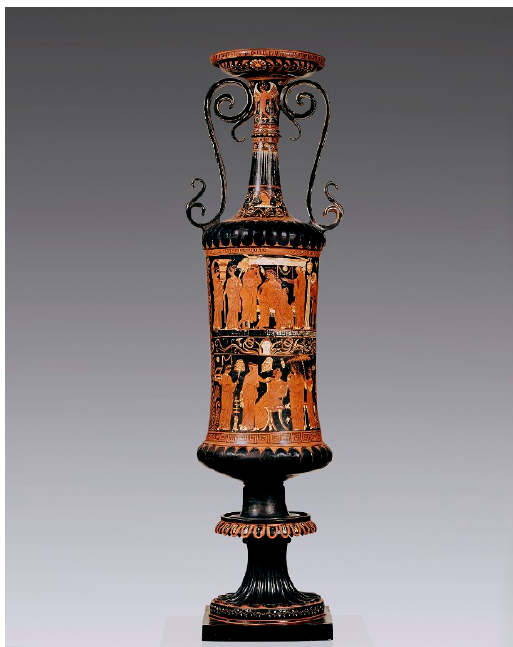
Figure 4. Basel, Antikenmuseum S 21 Apulian loutrophoros, Laodamia Painter, ca. 360–350 B.C. Eros moving to left in floral setting (neck), red-figure female head in floral setting (shoulder), death of Alcestis (upper band on body), frontal female head in added white in floral surround (central band on body), woman seated on klismos with two women on either side (lower band on body). Photograph © Antikenmuseum Basel und Sammlung Ludwig.